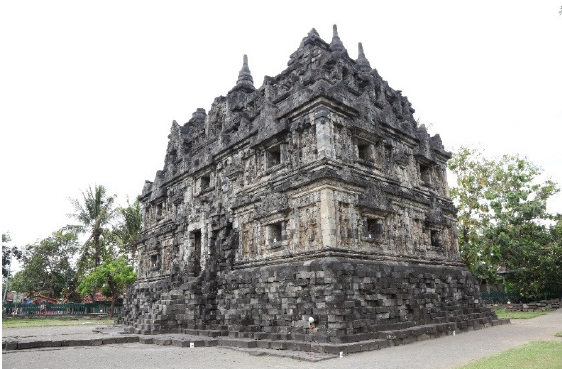
Figure 1. Candi Sari as photographed from its exterior.